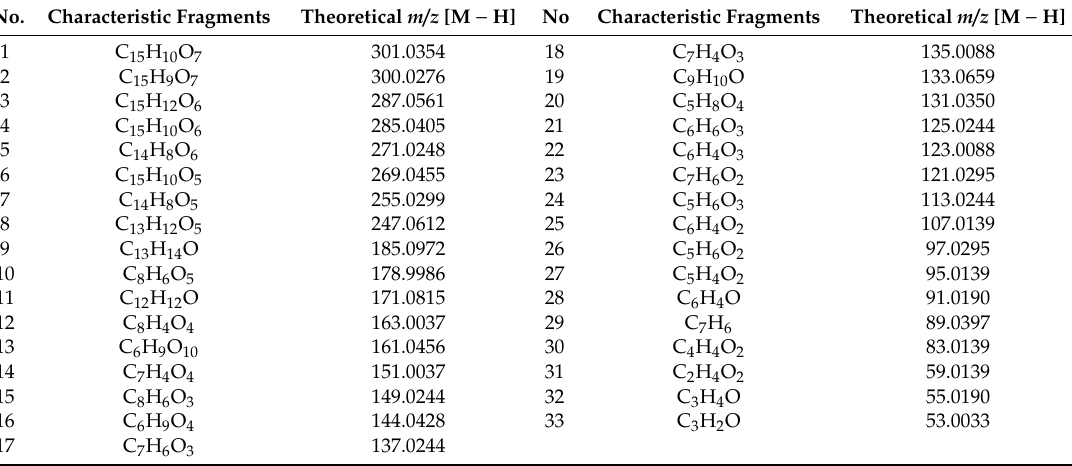
Table 1. Characteristic fragments of flavonoids and phenolic